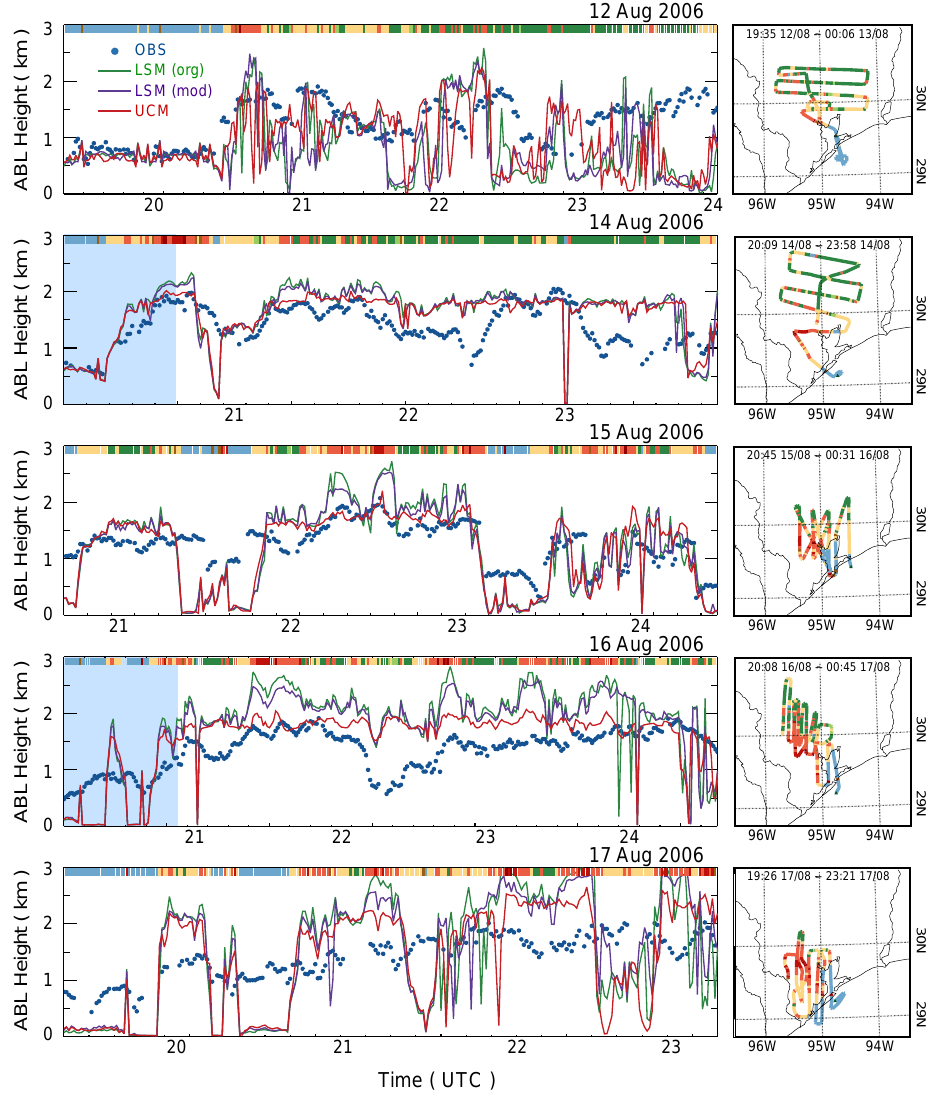
Fig. 13. Comparison of observed and simulated ABL heights (left panels) along the flight tracks (right panels) for the five days. Land-use types at the location of the aircraft are represented by colors that are the same used in Fig. 2. Time periods on the right panels indicate total flight